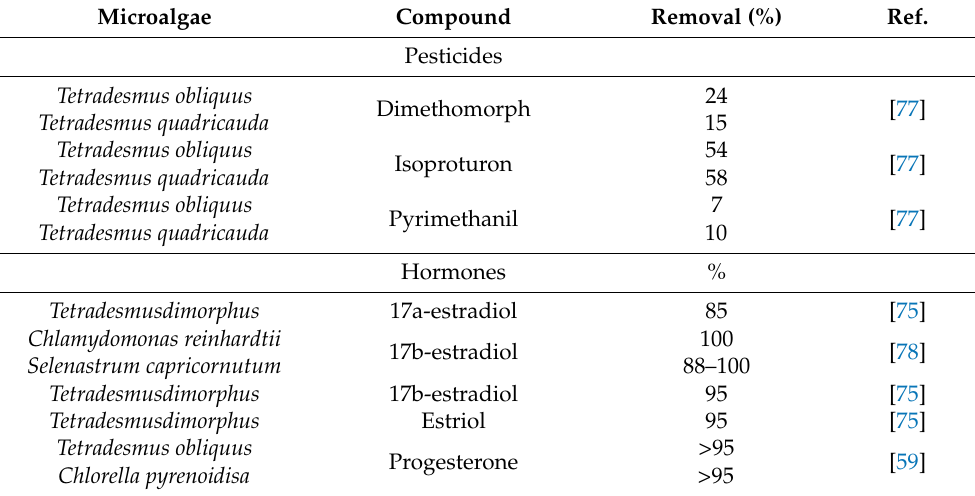
Table 4. Removal rate of pesticides, hormones, and heavy metals by microalgae. Microalgae Compound Removal (%)